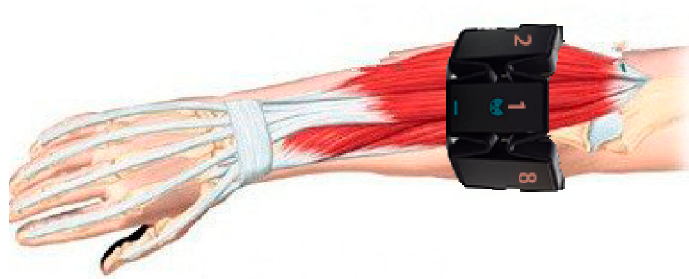
Figure 2. Wearing position and orientation.